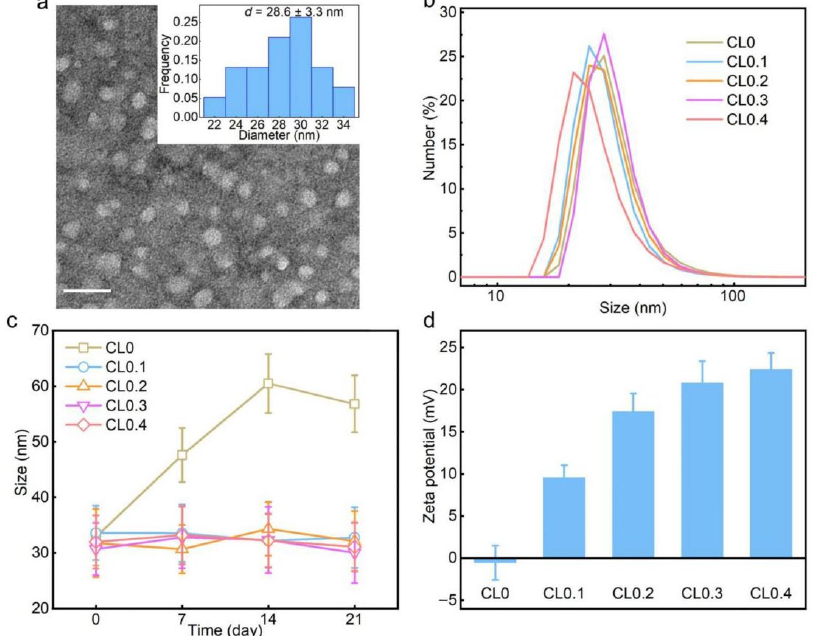
Figure 1. Characterization of CLs. ( a ) TEM image of CL0.4 and corresponding size distribution histogram (inset). Scale bar = 50 nm. ( b ) Hydrodynamic diameter distributions of CL0, CL0.1, CL0.2, CL0.3, and CL0.4 measured by DLS. ( c ) Changes of the hydrodynamic diameters of different CLs within 3 weeks. ( d ) Zeta potentials of CLs in PBS.